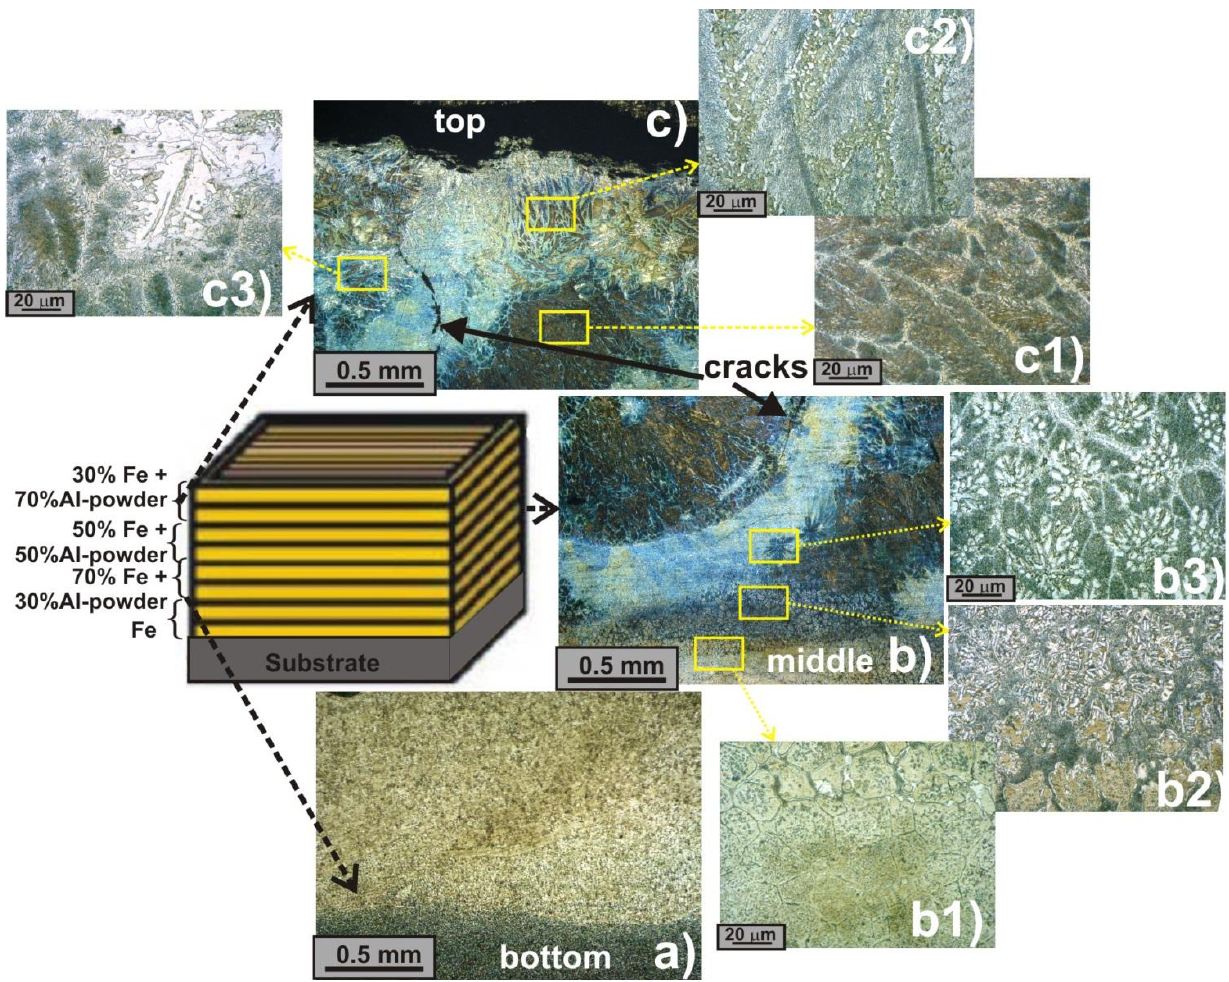
Figure 3. Optical metallography micrographs showing the typical microstructures of 3D laser clad coating of Fe–Al multilayer system: ( a ) bottom layers ~2–4 mm from substrate; ( b ) middle layers ~4–6 mm from substrate; ( c ) top layers ~6–8 mm from substrate. The conditions below the LB regime were: P = 800 W, V = 500